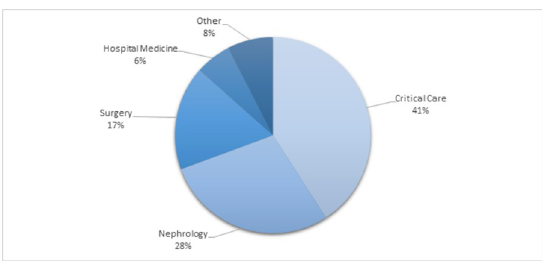
Fig 2. Albumin administrations as prescribed by specialty. Other: Gastroenterology, physical medicine, cardiology, respiratory, emergency medicine, gynecology